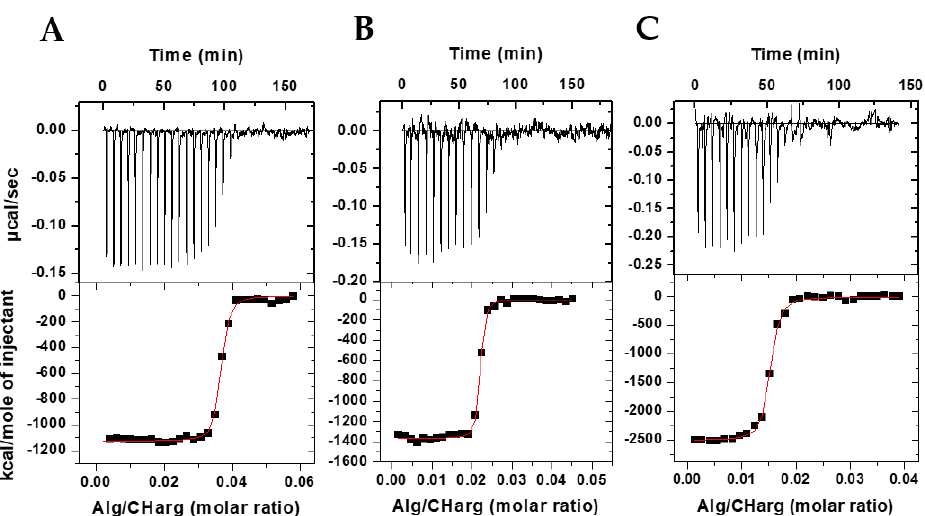
Figure 1. ITC results at 25 °C, pH 4.5, for interaction between alginate and CHarg in the presence of JM72 polypeptide at different concentrations: ( A ) 2.5 µM; ( B ) 7.5 µM; ( C ) 15 µM.